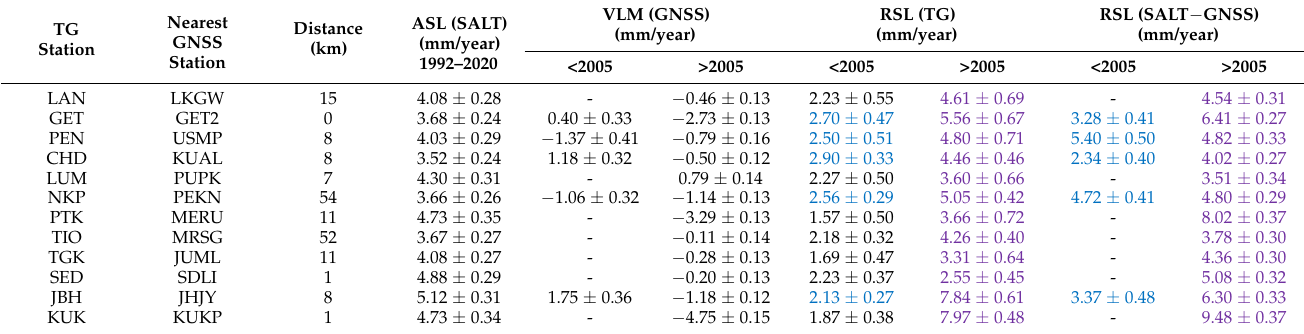
Table 8. RSL comparison (TG versus SALT − VLM) for 12 locations in Peninsular Malaysia. Shown are the final ASL, VLM (from the nearest GNSS station), RSL (from TG), and RSL (from SALT − GNSS). For all TG locations, the RSL (TG) trend estimates were split (<2005 and >2005). For the VLM, this was only possible for TG locations GET, PEN, CHD, NKP, and PEN since no VLM data were available here before 2005. In blue and purple, the values to be compared are highlighted, which are either two periods (<2005 and >2005) or one period (>2005) for locations where the MyRTKNet stations only became operational after 2005. The distance from the TG to the nearest GNSS station is also given. All error estimates are given at a 95% confidence level (1.96 sigma).